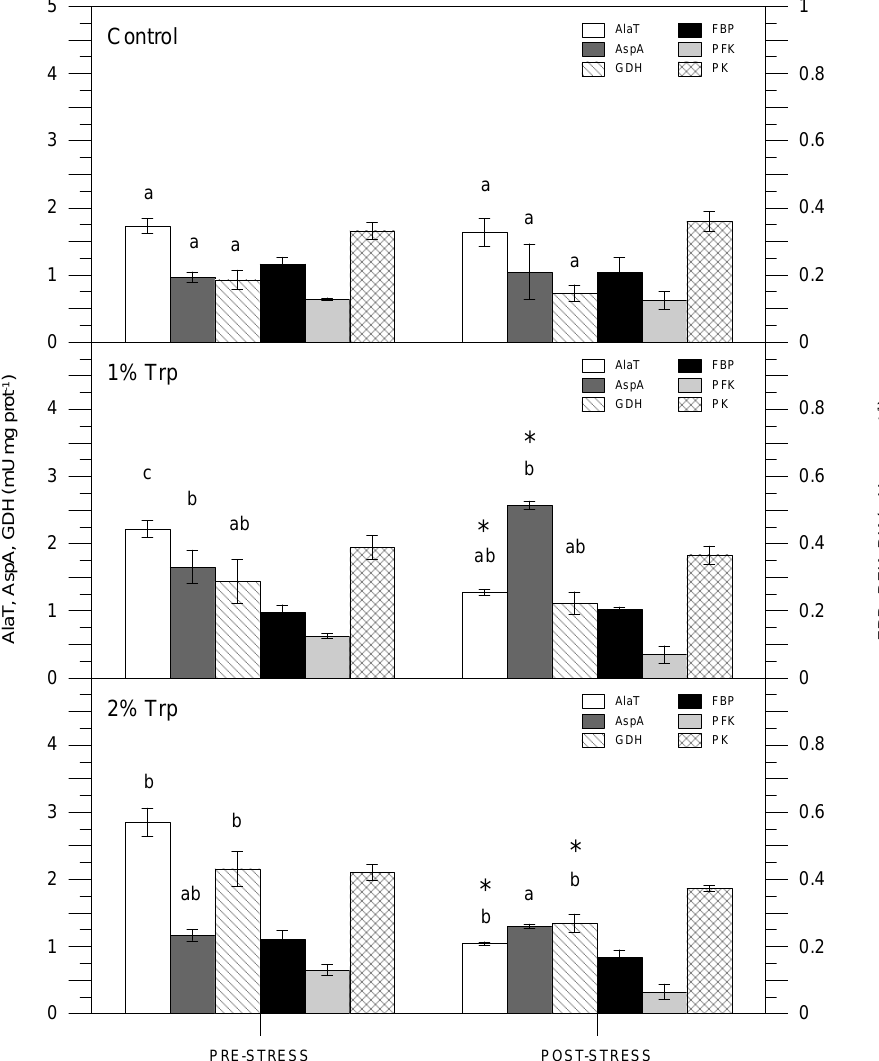
Figure 6. Hepatic enzyme activities (AlaT, AspA, GDH, FBP, PFK and PK) for the eight-day treatment. Different letters indicate significant differences among groups (experimental feeds) within each condition, and asterisks show significant differences between pre- and post-stress condition within each feed type.